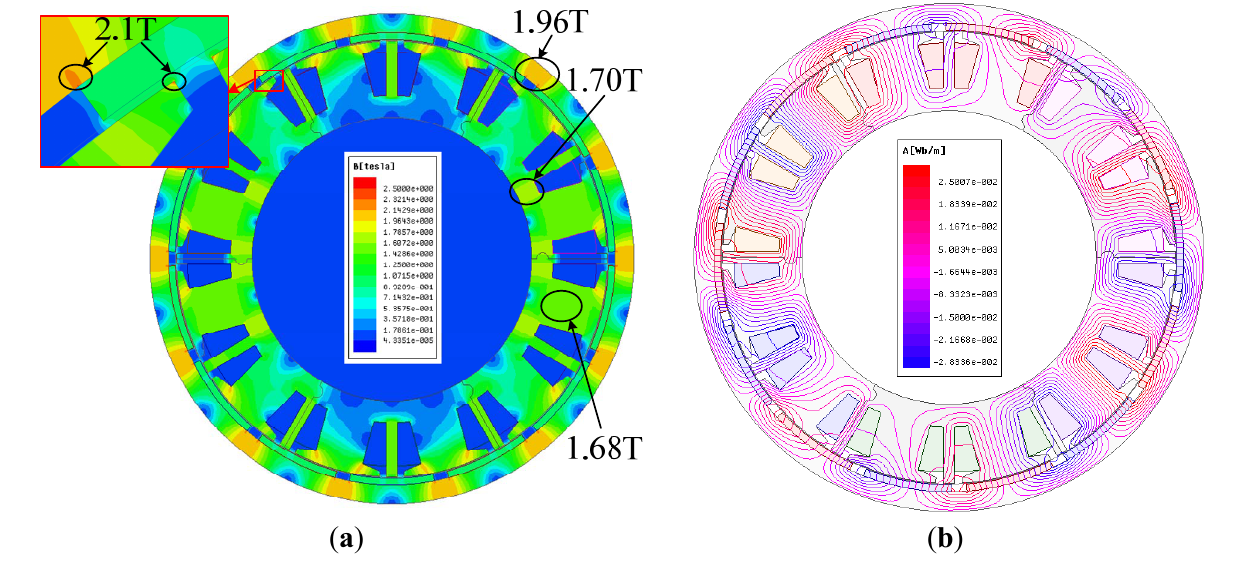
Figure 10. Flux density distribution and flux lines@450 rpm with rated load: ( a ) flux density map; and ( b ) winding-produced flux